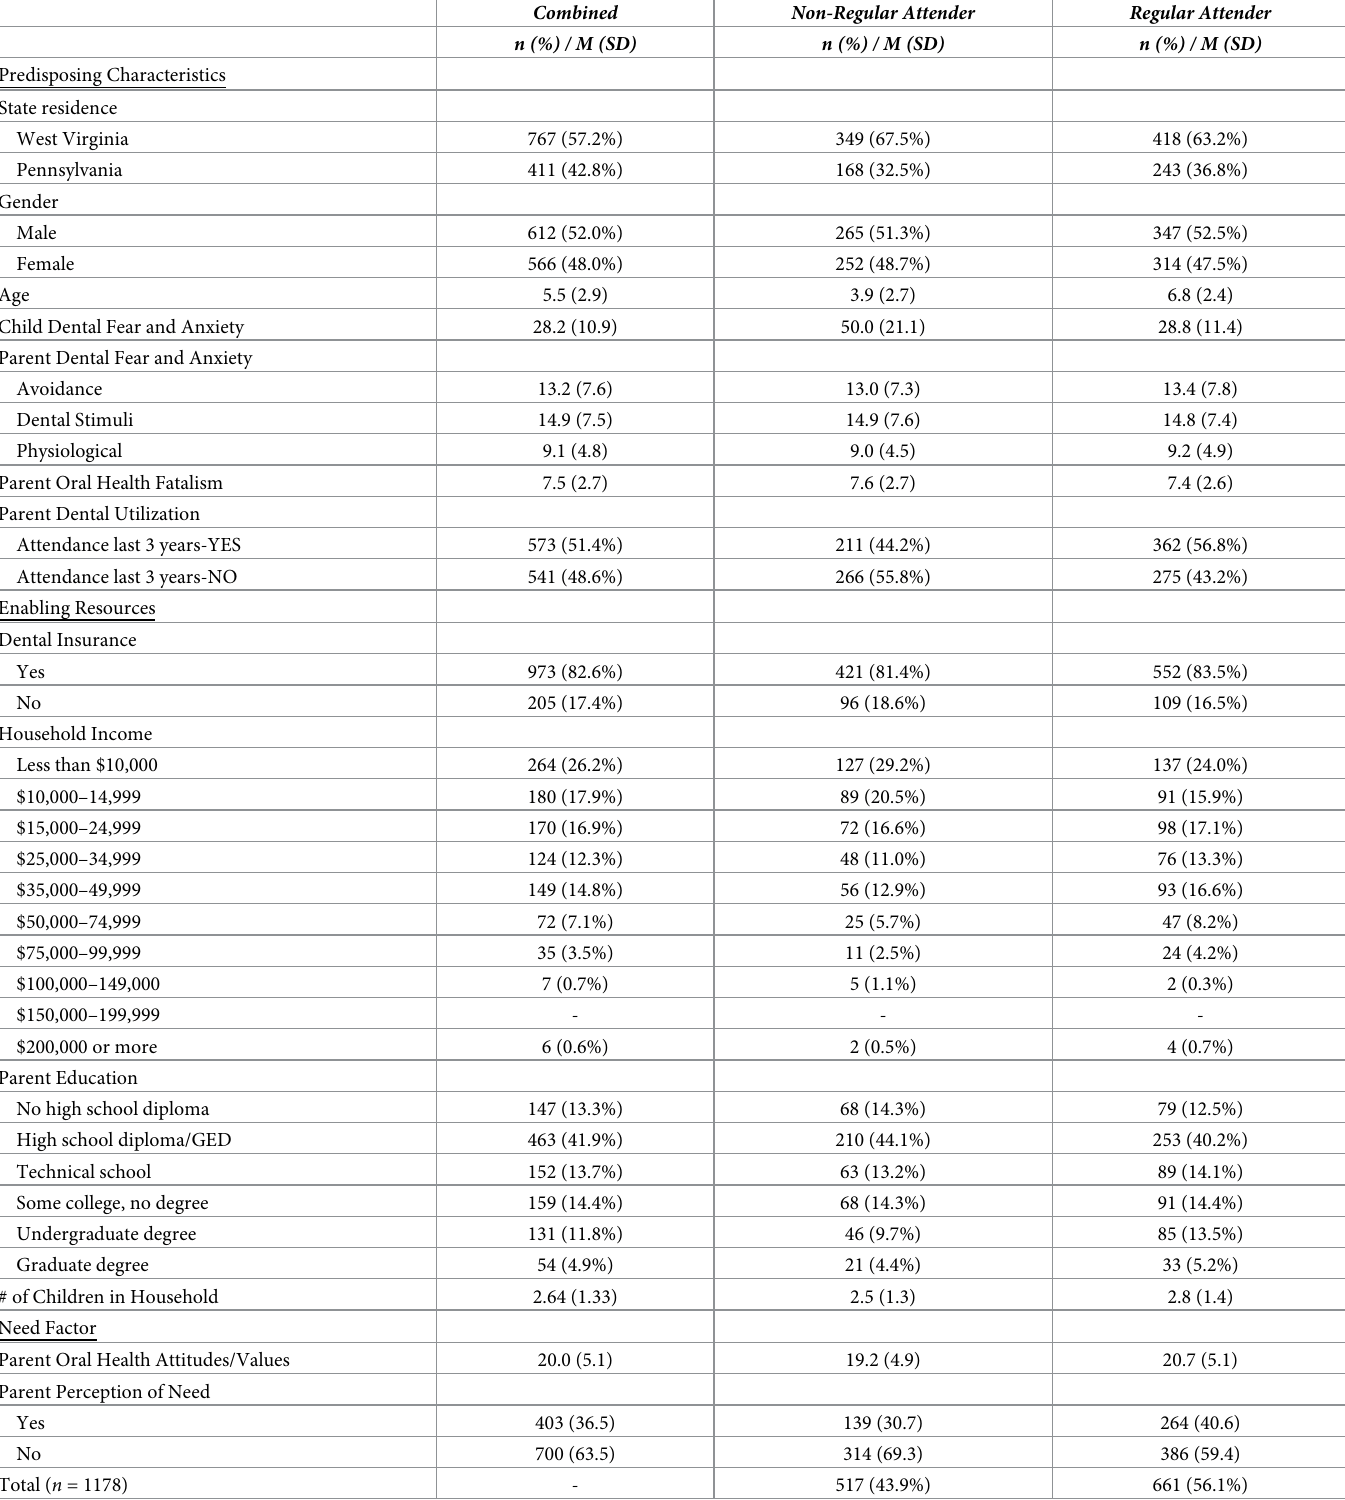
Table 1. Sample characteristics (n =